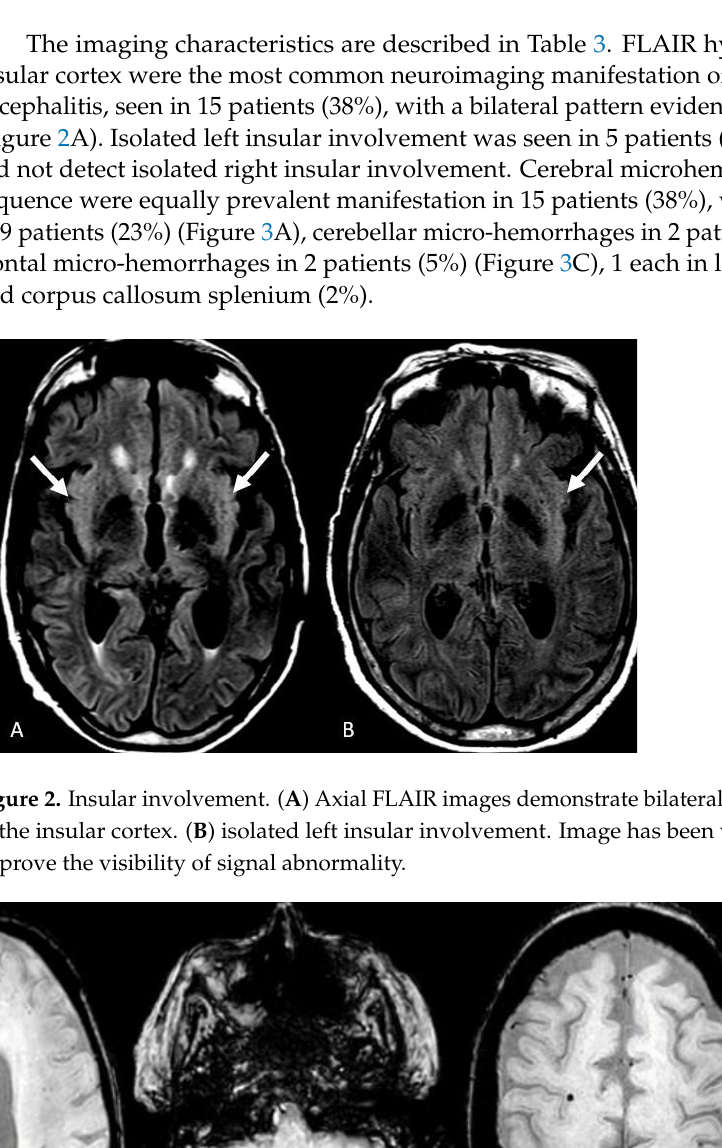
The imaging characteristics are described in Table 3. FLAIR hyperintensities in the insular cortex were the most common neuroimaging manifestation of the COVID-induced (Figure 2A). Isolated left insular involvement was seen in 5 patients (12)% (Figure 2B). We